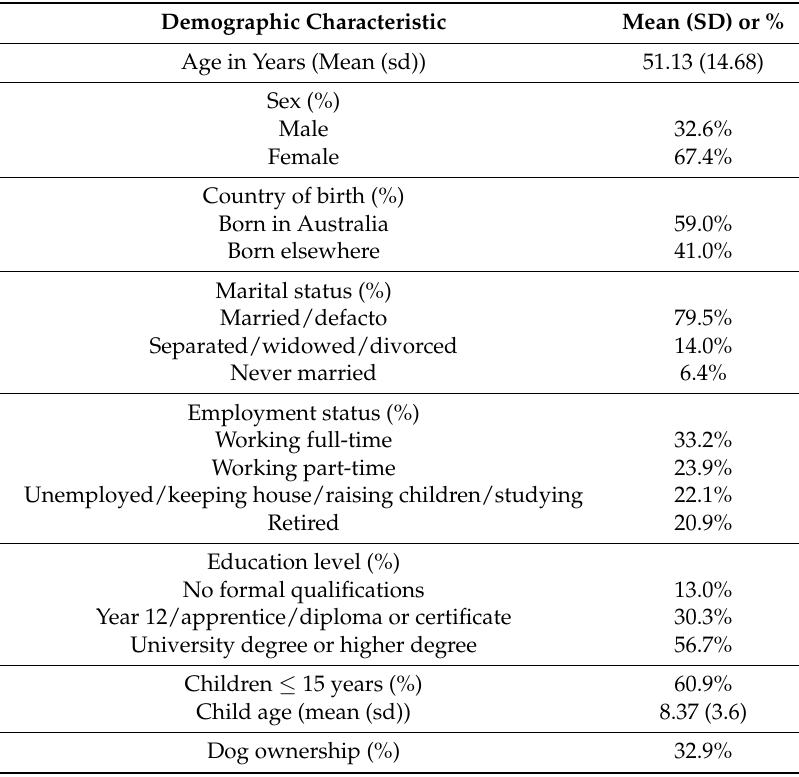
Table 1. Demographics of questionnaire respondents ( n =